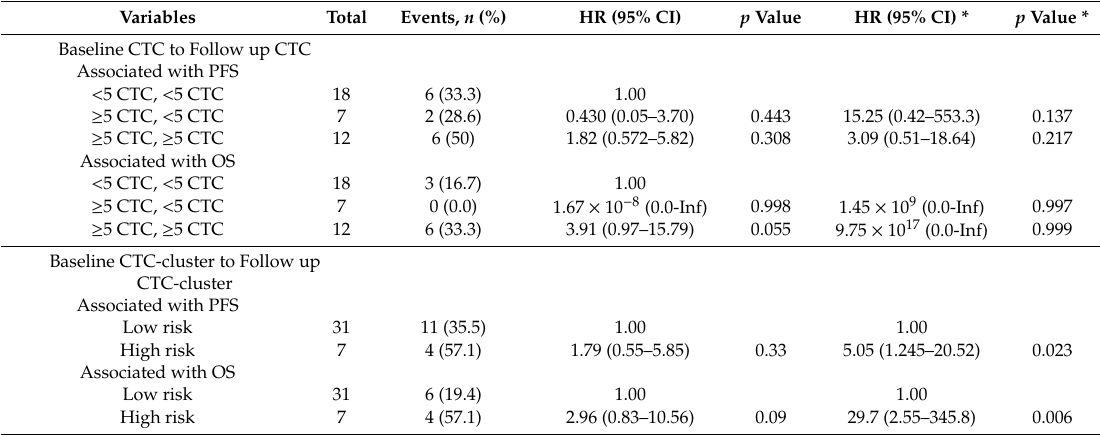
Table 4. Change in CTC and CTC-cluster count from baseline to follow